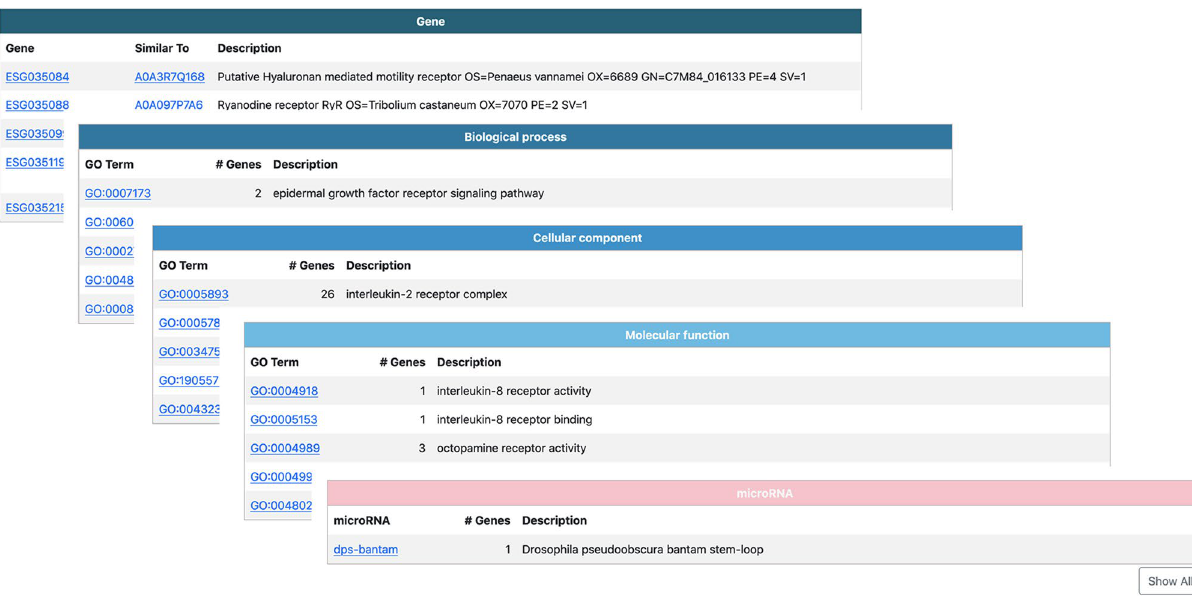
Figure 5. New search engine of KrillDB 2 . Example of the results of a full-text search on KrillDB 2